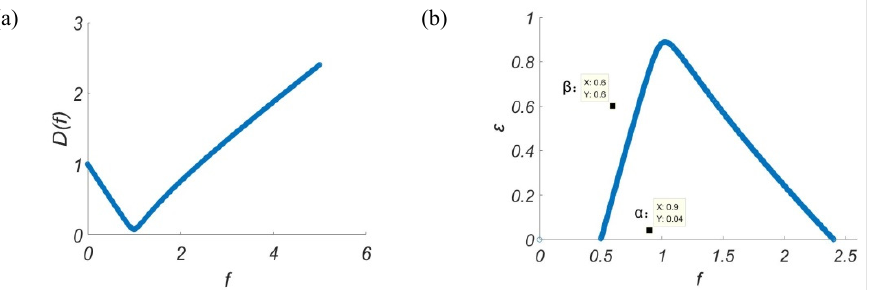
Figure 1. ( a ) The relationship between f and D(f) . ( b ) Critical points of Belousov–Zhabotinsky (B-Z) reaction self-oscillation.